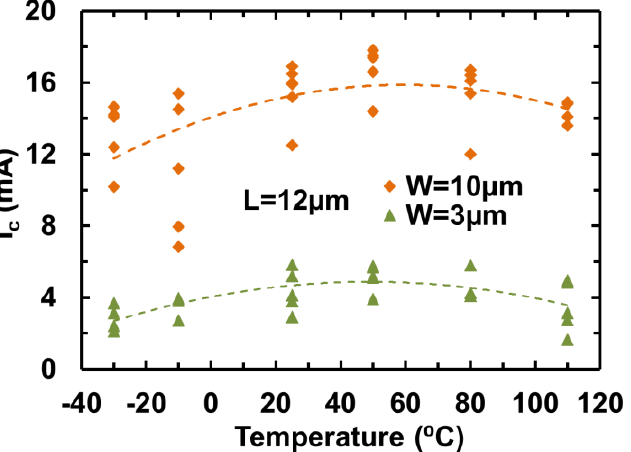
Figure 33. Statistics for TLP-measured I C ~T behavior (−30 °C to +110 °C) for GNR wire samples show optimal annealing temperature [50].